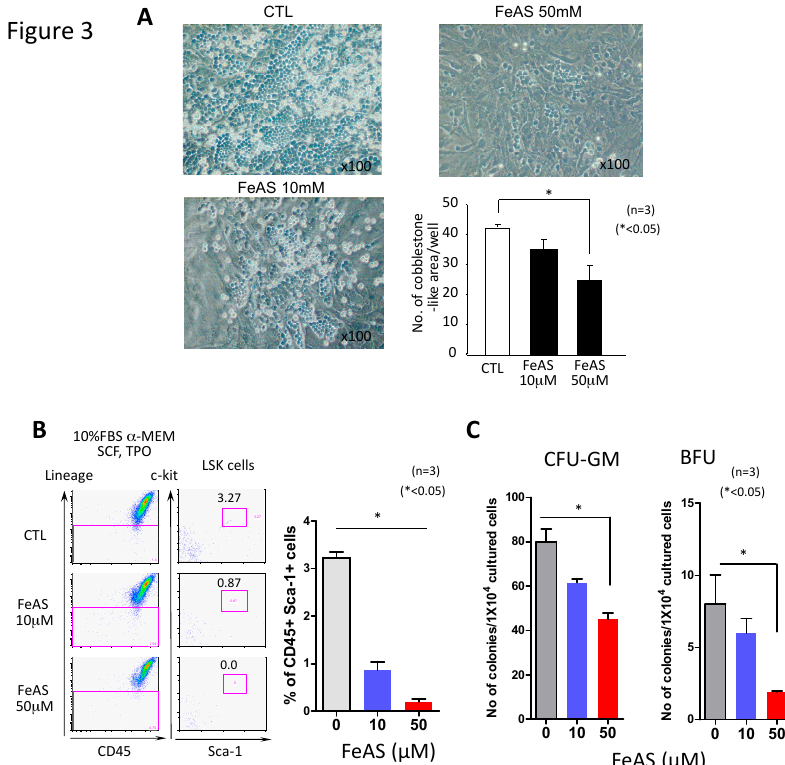
Figure 3. FeAS inhibits hematopoietic cell maintenance in co-culture system with MS5 stroma cells. ( A ) LSK cells (100 cells/well) were plated on pre-established monolayers of MS5 cells in a 24-well plate. After 3 or 4 days of culture in 10% FBS α MEM containing SCF and TPO (100 ng/mL each) with or without FeAS, the numbers of cobblestone-like areas were counted. Pictures of representative cobblestone-like areas from three independent experiments are shown. Original magnification: 100 × ( B ) LSK cells were cultured on MS5 cells for 7 days with or without FeAS and subjected to flow cytometry. Cells were stained with anti-Lin, anti-Sca-1, and c-Kit antibodies and analyzed using a FACS Canto II. Numbers in the boxes are the percentages of each fraction. Representative flow cytometry data from one experiment are shown (left panel) and summarized data (mean ± SD) from three independent experiments is shown in the right panel (* p < 0.05). ( C ) Primary BM MNCs were cultured on MS5 with or without FeAS for 7 days and colony assays were performed. All cultures were conducted in triplicate and BFU and CFU-GM colonies were visualized, identified and scored in a light microscope after 10 days of culture. Results are shown as mean ± SD ( n = 3, * p < 0.05). Next, we performed colony assays with MNCs cultured in semisolid medium with or without FeAS for 7 days, and found that the numbers of CFU-Mix, BFU-E, and CFU-GM were reduced upon